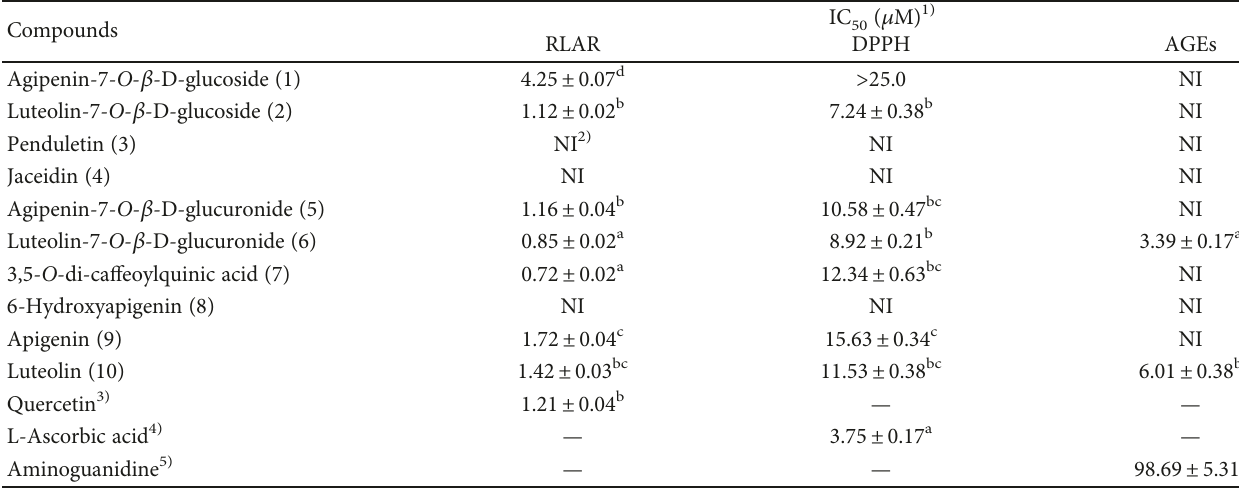
Table 2: Inhibitory activities of compounds isolated from Matricaria recutita L. on rat lens aldose reductase (RLAR), DPPH radical scavenging, and advanced glycation end products (AGEs).